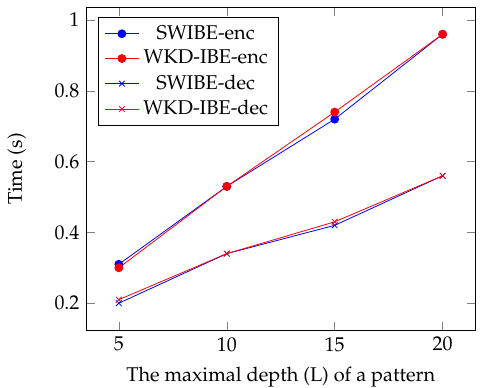
Figure 2. Encryption and decryption time in SWIBE and